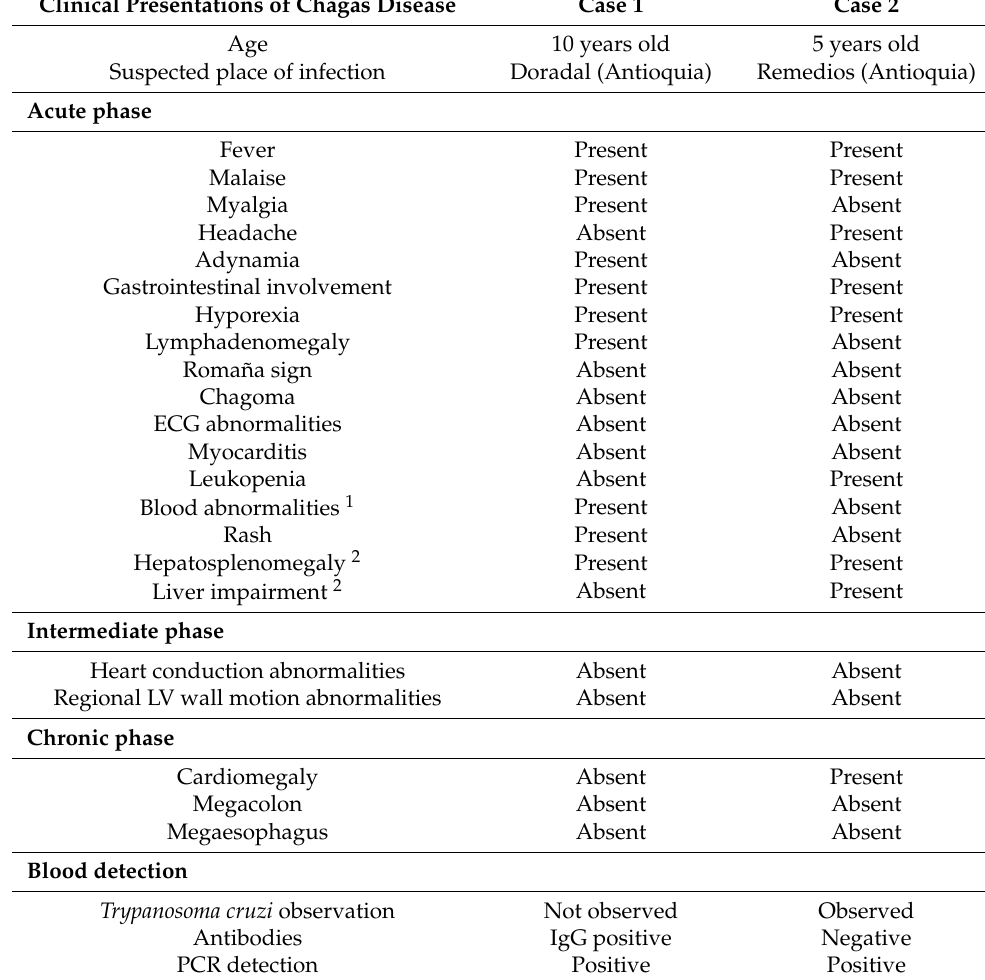
Table 1. Chagas disease clinical profiles from two acute cases in Antioquia Department, Colombia, diagnosed in 2019 and